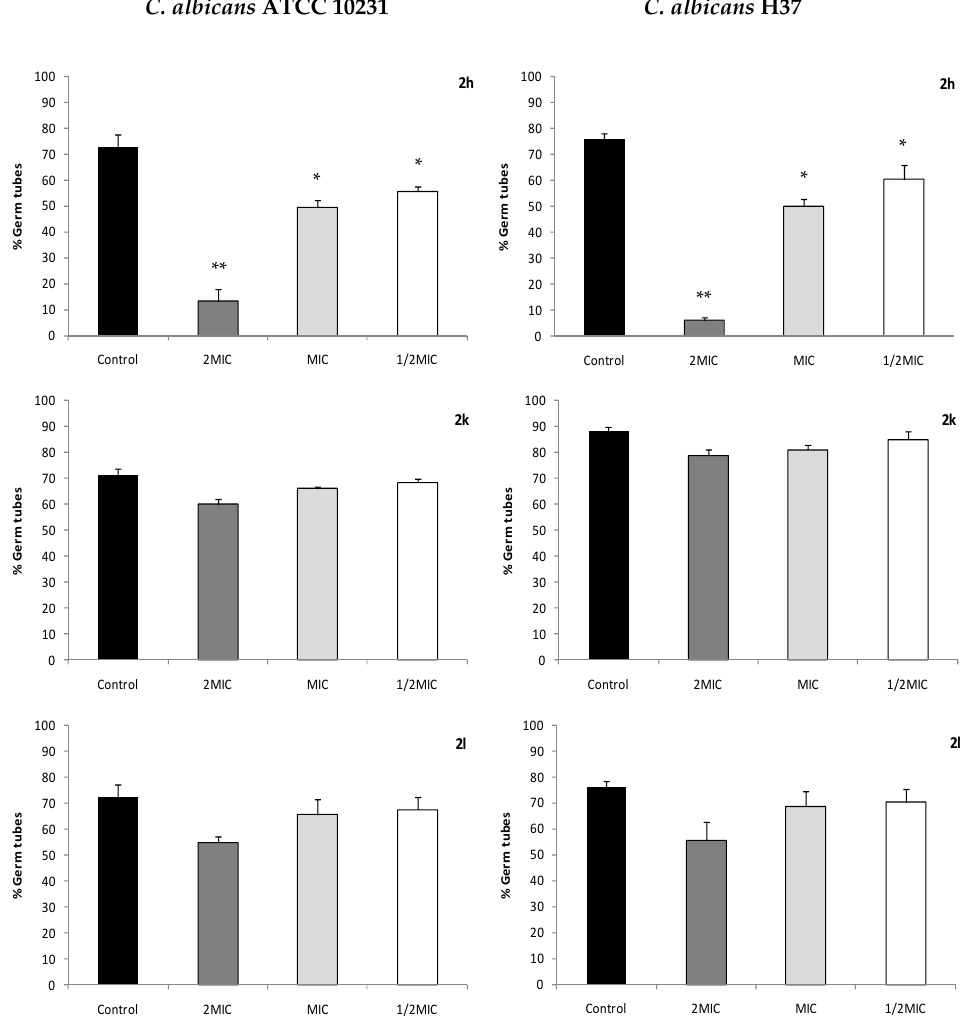
Figure 4. Percentage of germ tube formation by two Candida albicans strains (ATCC 10231 and H37) with different concentrations of 5-aminoimidazole-4-carbohydrazonamides derivatives. Results show means ± SEM of three independent experiments. Controls included 1% of DMSO. MIC: minimal inhibitory concentration. * p < 0.05; ** p < 0.001 (one-way ANOVA followed by Dunnett’s test).